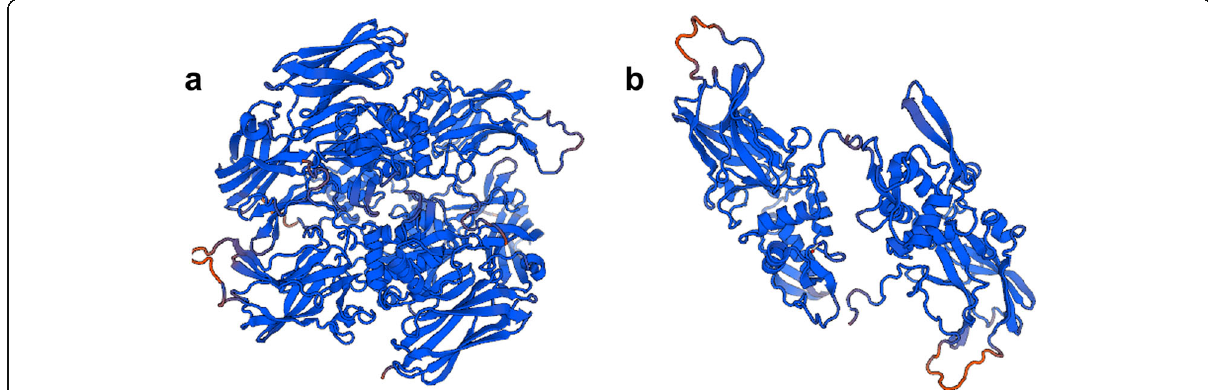
Fig. 3 The three-dimensional structure of the FXIIIA subunit. a : the wild type; b : the mutant (p.Cys328stop). The three-dimensional structures of the wild-type and the mutant F13A1 protein generated by the SWISS-MODEL online software shows obvious differences, in which p.Cys328stop resulted in the termination of translation and the protein features were